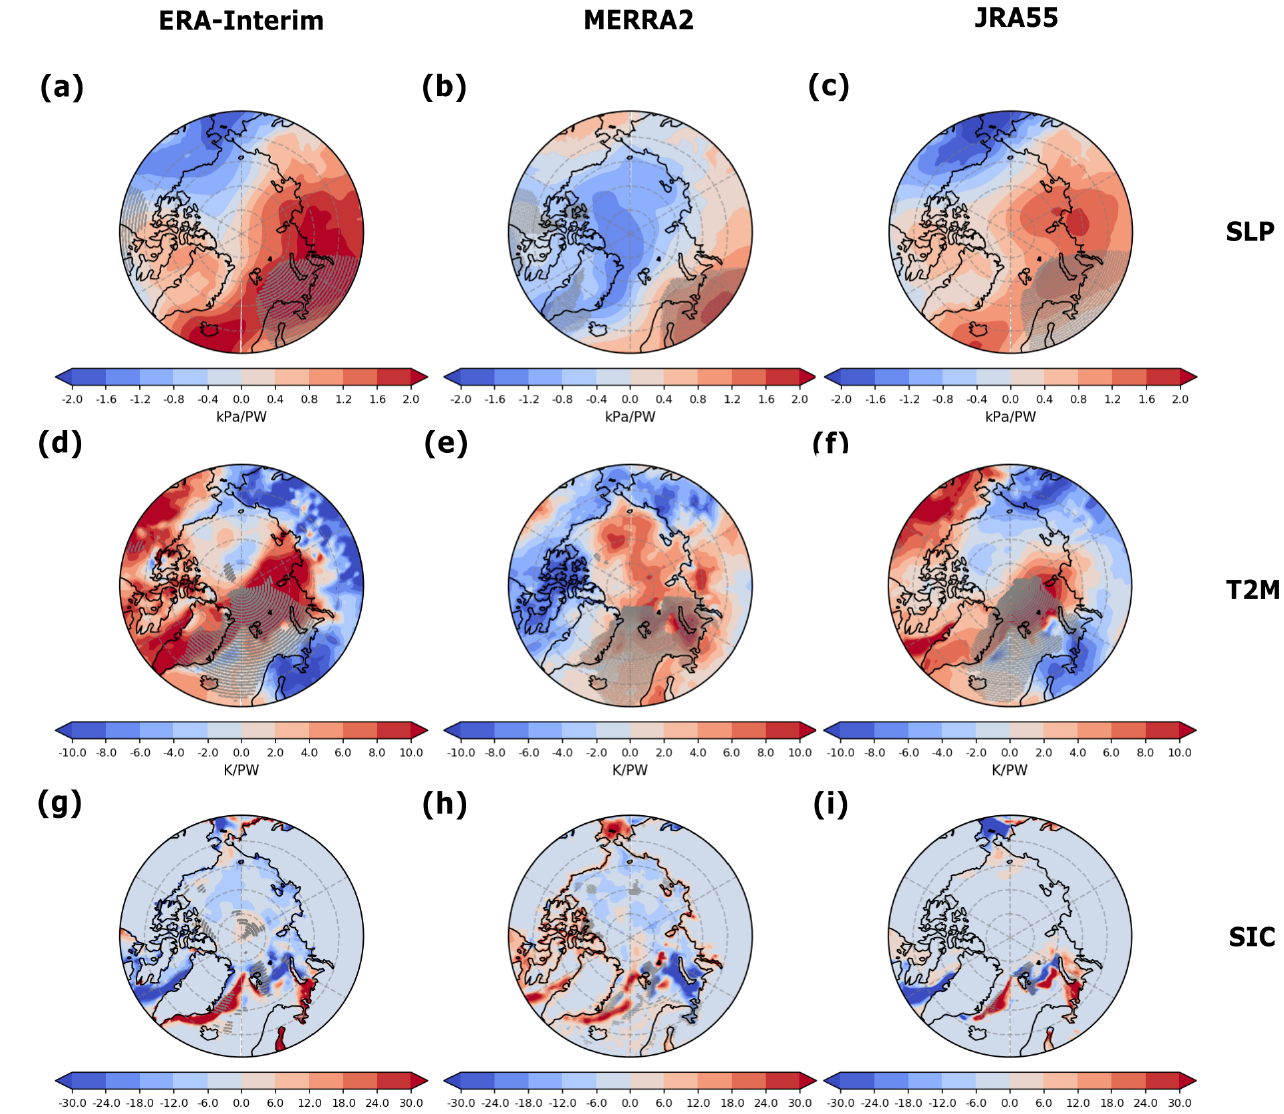
Figure 9. Regressions of sea level pressure, 2m temperature and sea ice concentration anomalies on AMET anomalies at 60 ◦ N in win- ter (DJF) at interannual timescales with no time lag. The monthly mean fields are used here after taking a running mean of 5 years. Both the 2m temperature and sea ice concentration are detrended. From left to right, they are the regressions on AMET of (a, d, g) ERA-Interim, (b, e, h) MERRA-2 and (c, f, i) JRA-55. The stippling indicates a significance level of